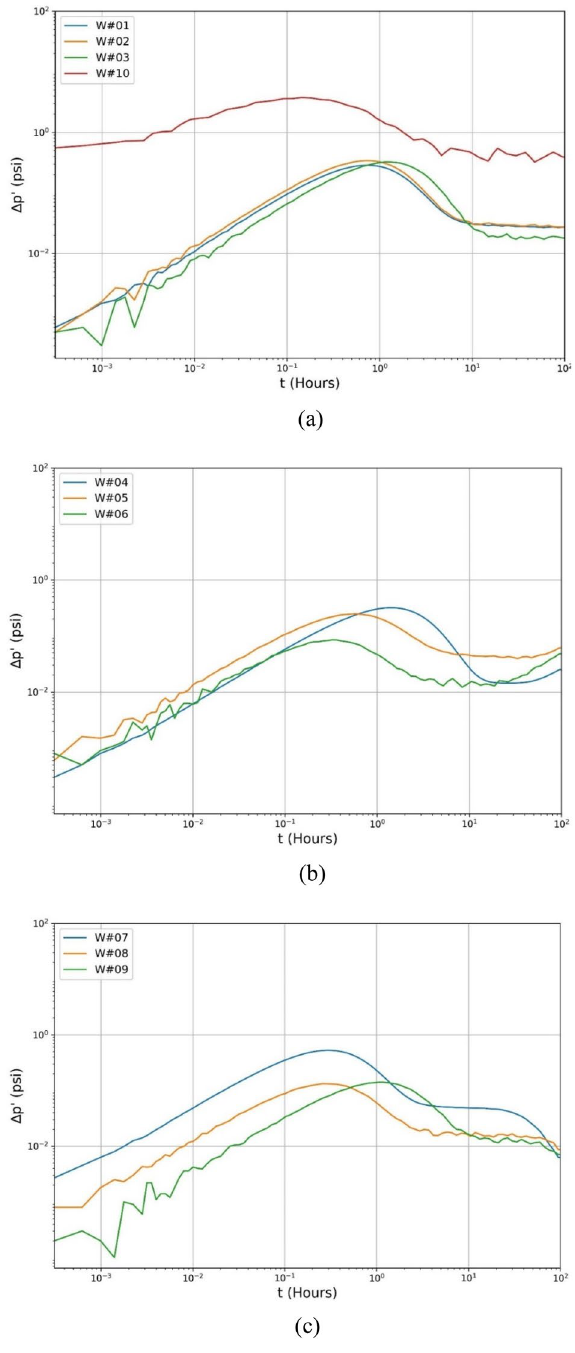
Figure 1. Illustration of ∆p’ curves for the ( a ) HO-IA, ( b ) HO-NF, and ( c ) HO-PS